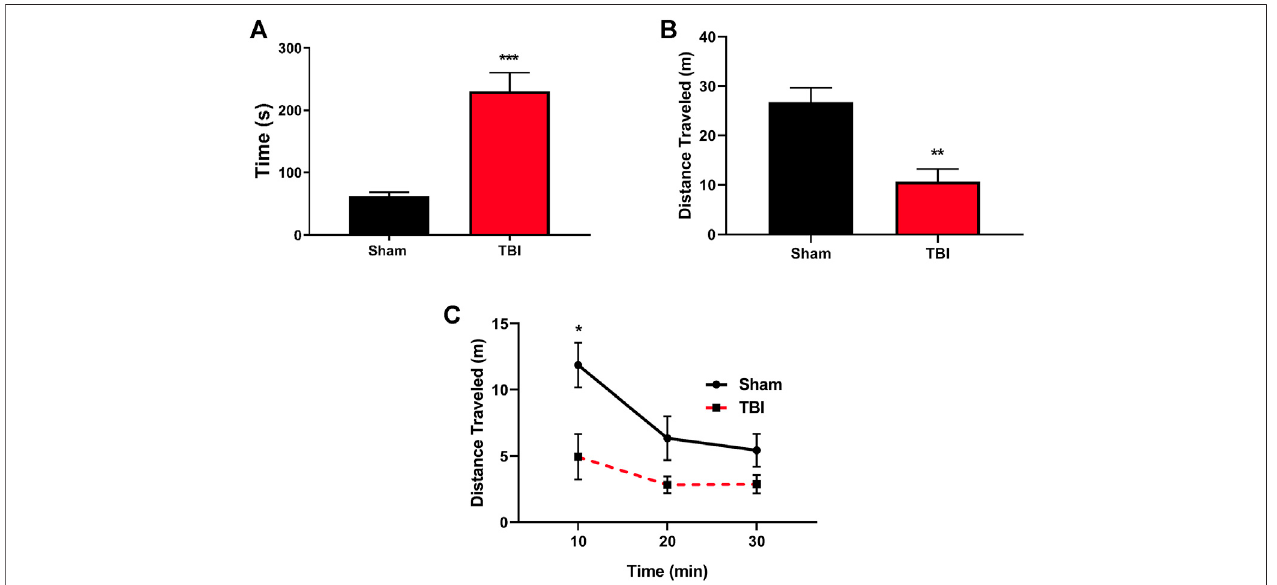
FIGURE 1 | mTBI results in signi fi cant increases in RRT and altered locomotion following the injury. (A) mTBI results in signi fi cant increases in righting re fl ex time (RRT),indicative ofaloss ofconsciousness inmTBI subjectsascompared totheirsham counterparts immediatelyfollowing injuryparadigm ( t =5.31, ***p ≤ 0.0001, N = 11 sham, 12 TBI). (B) Total locomotor activity three hours post-mTBI or sham paradigm. mTBI subjects exhibit a signi fi cant reduction in total locomotor activity acutely followinginjuryparadigm( t =4.22,** p ≤ 0.001, N =7/group). (C) LocomotoractivitybinnedovertimerevealedthatmTBIsubjectsexhibitareductioninexploratory activity immediately upon exposure to a novel environment [F (1,12) = 7.644, p = 0.017, t = 2.870, * p ≤ 0.05, N = 7/group] as compared to their sham